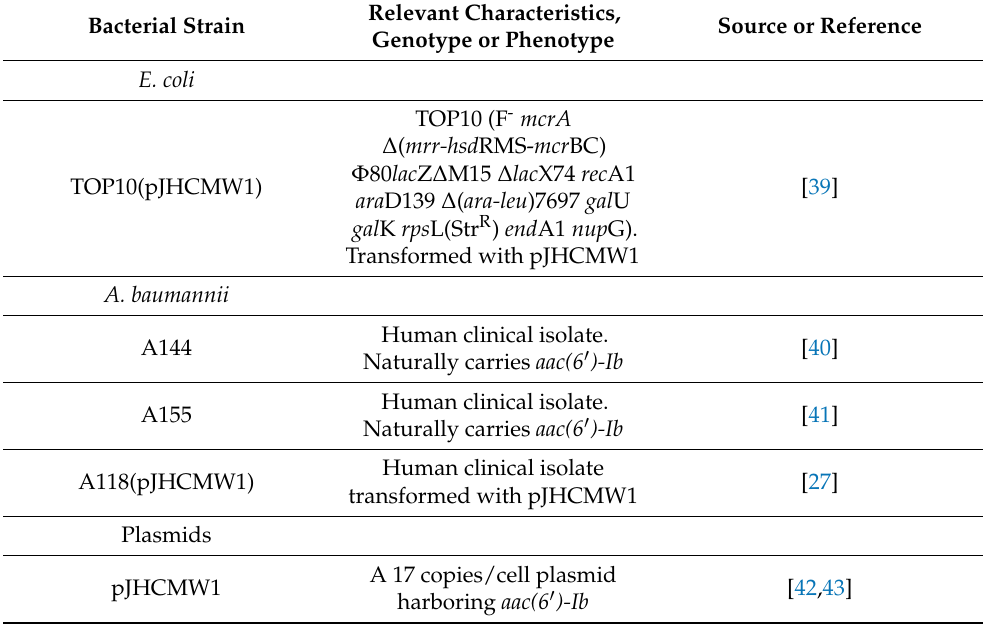
Table 1. Bacterial strains and plasmids used in this